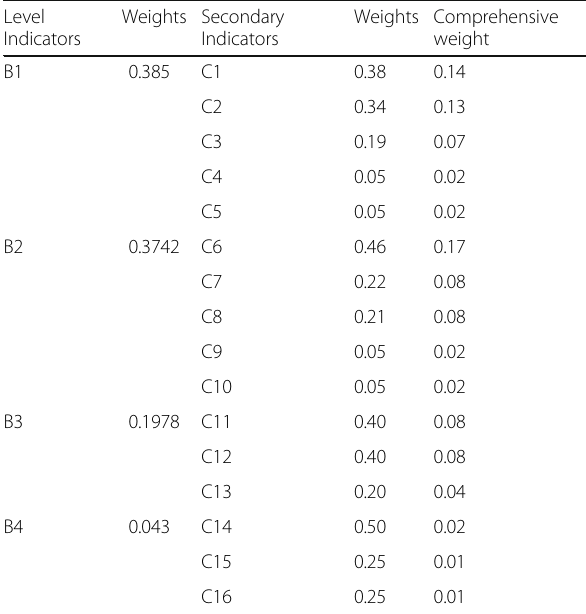
Table 19 Final score for ports of Wilhelmshaven, Hamburg, Bremen, and Bremerhaven under AHP. (Source: